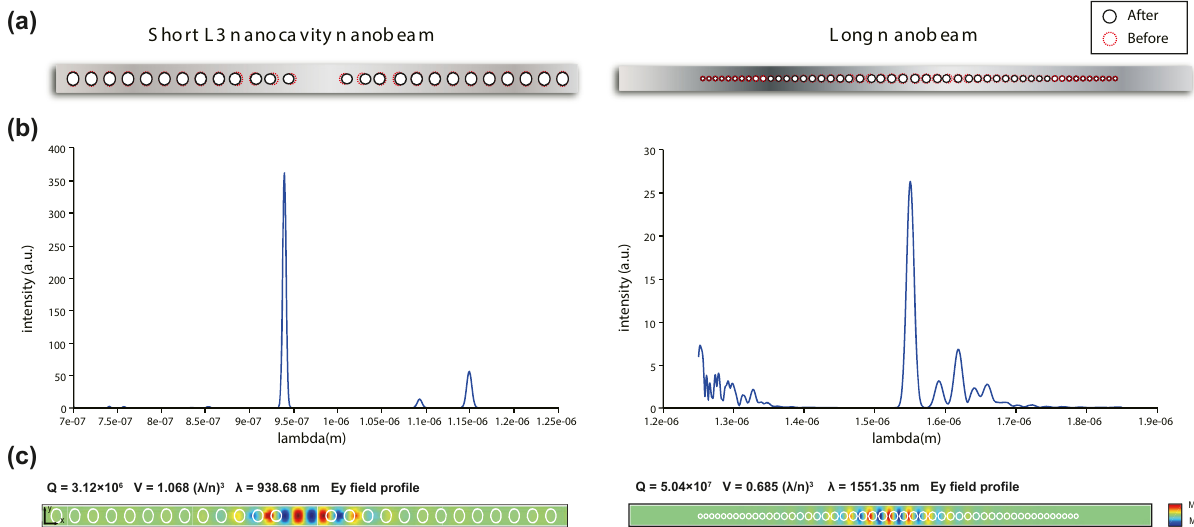
Figure 5: Physical structures, spectra, and electric field profiles ( E ) of the inverse designed nanobeams from Table 2. Left panel: L3 nanobeam’s y solved structure, spectrum and electric field profile, respectively; right panel: long nanobeam’s solved structure, spectrum and electric field profile, respectively. In (a), red dashed circles correspond to the original holes, whereas black solid circles represent the resulting holes from L2DO’s inverse design solution. Results in (b) and (c) are generated by 3D FDTD simulations. y -axes of the spectra in (b) represent the intensity of the EM field whereas field plots in (c) display the x -axes represent wavelengths. A single highest peak in a spectrum corresponds to a single resonance mode. E y electromagnetic resonance modes of the retrieved nanobeam structures, where the verified Q , V , and 𝜆 are also labelled. Resonance modes are necessary for lasing